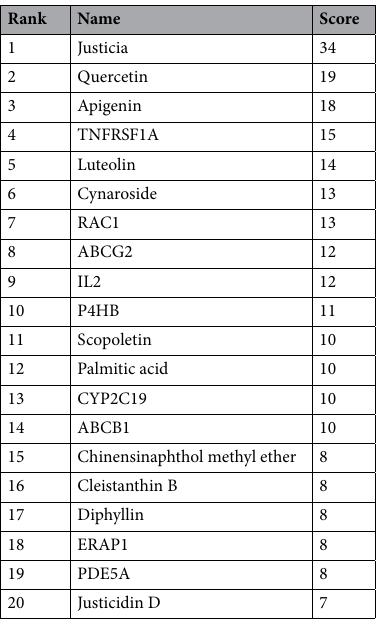
Table 2. Top 20 nodes in the network constructed by Herb-Compounds-Common